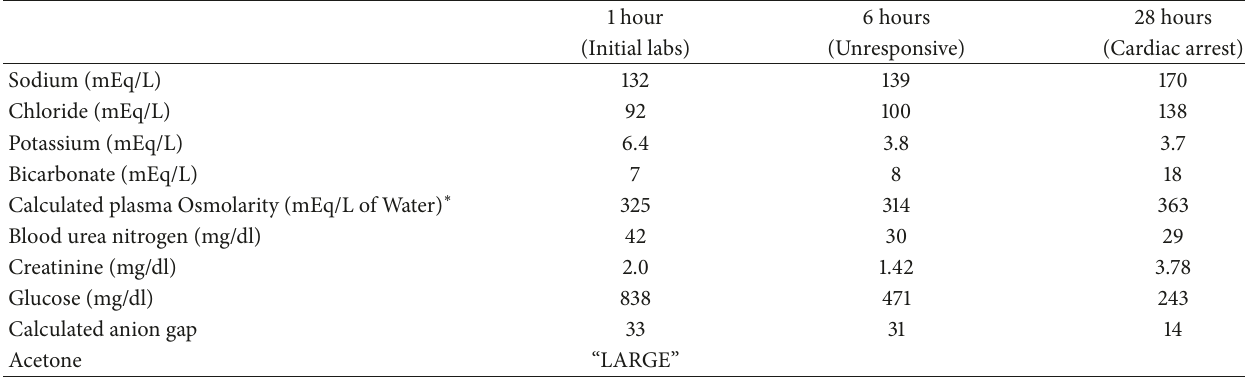
Table 1: Lab values during the patient’s clinical course. Timing is shown from time of initial evaluation and blood glucose reading from handheld glucometer.